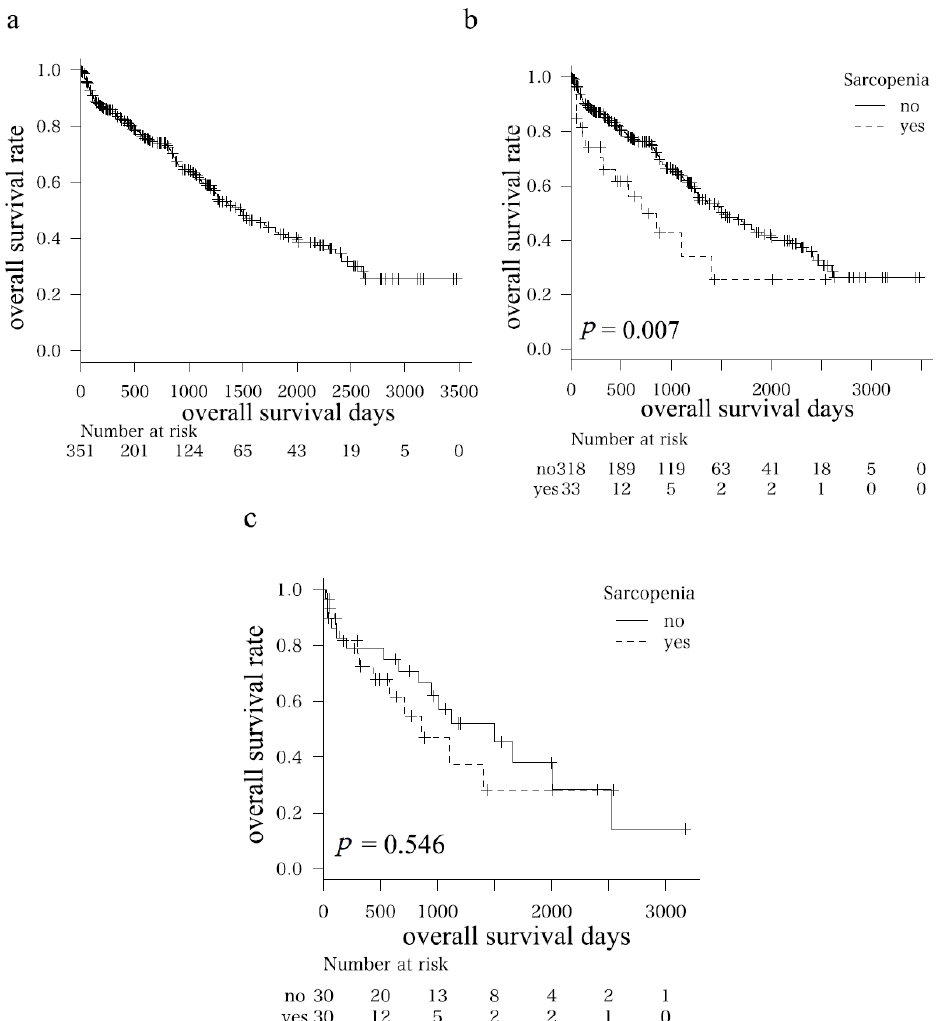
Figure 1. Kaplan–Meier curves for overall survival time in ( a ) all patients; ( b ) subgroups (i.e., sarcopenia and non-sarcopenia groups); and ( c ) subgroups after adjustments for possible confounding factors (age, sex, Child–Pugh score, maximum tumor size, tumor number, and the degree of portal vein invasion) using propensity score matching analysis. Table 2. Baseline demographic and clinical characteristics of sarcopenia and non-sarcopenia groups.